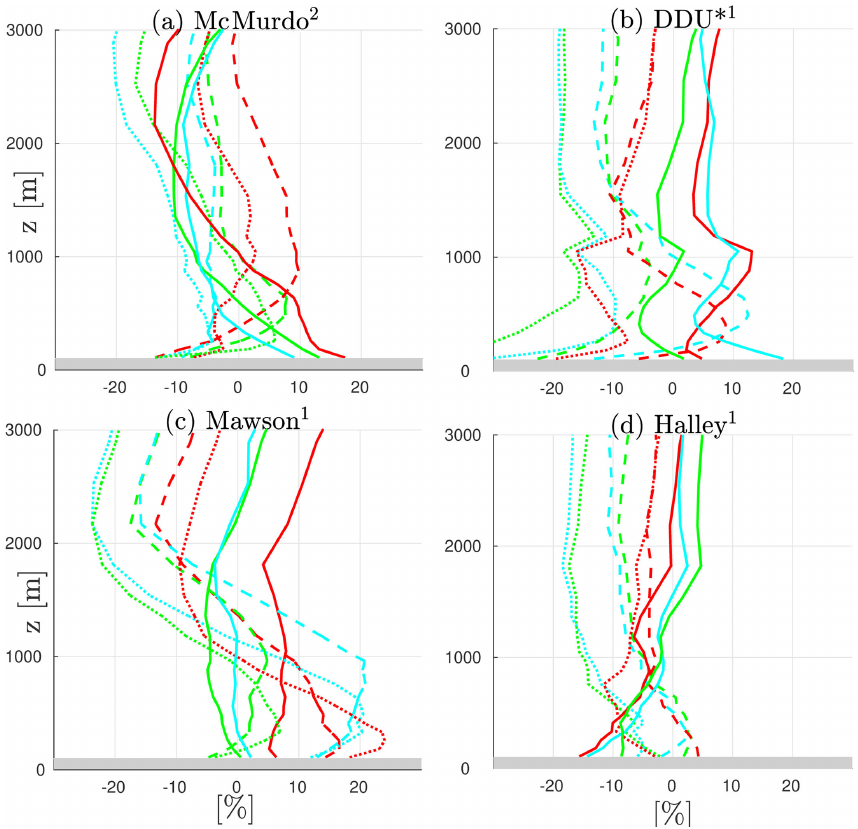
Figure 8. Yearly median differences (solid lines), 80–20th interquartile difference (dashed lines) and 9–5th interquartile difference (dotted lines) with respect to radiosoundings of RHi at four Antarctic stations. Panels (a, b) show the DJF subset, panels (c, d) the JJA subset. Red, green and cyan lines refer to Polar WRF, ERA5 and ERA-I, respectively. Grey strips delimit the first 100m above the ground surface. Numbers in exponential form next to station names in the title indicate the number of radiosoundings per day at the corresponding